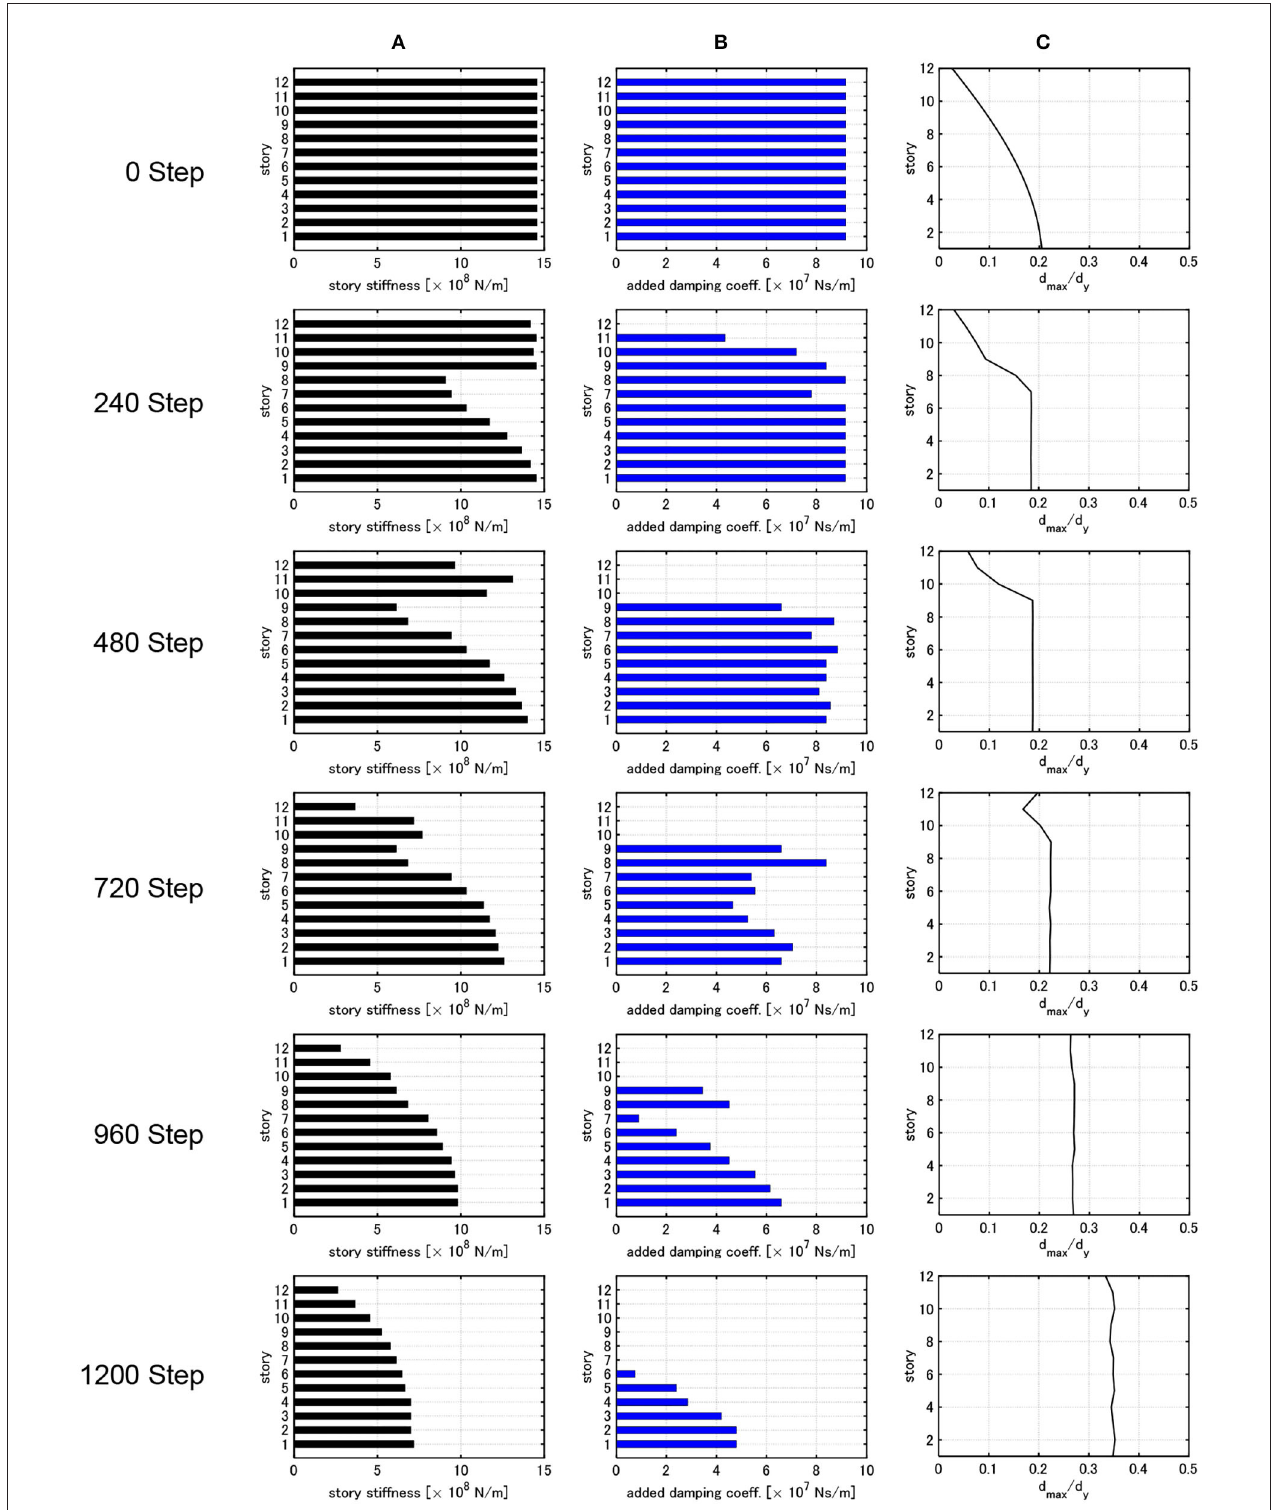
FIGURE 4 | Change of distribution of story stiffness, distribution of added damping coefficient and distribution of d max, i / d y throughout process of optimization ( n k = n c = 1, n kc = 600). (A) Distribution of story stiffness. (B) Distribution of damper damping coefficient. (C) Distribution of d max, i / d y .